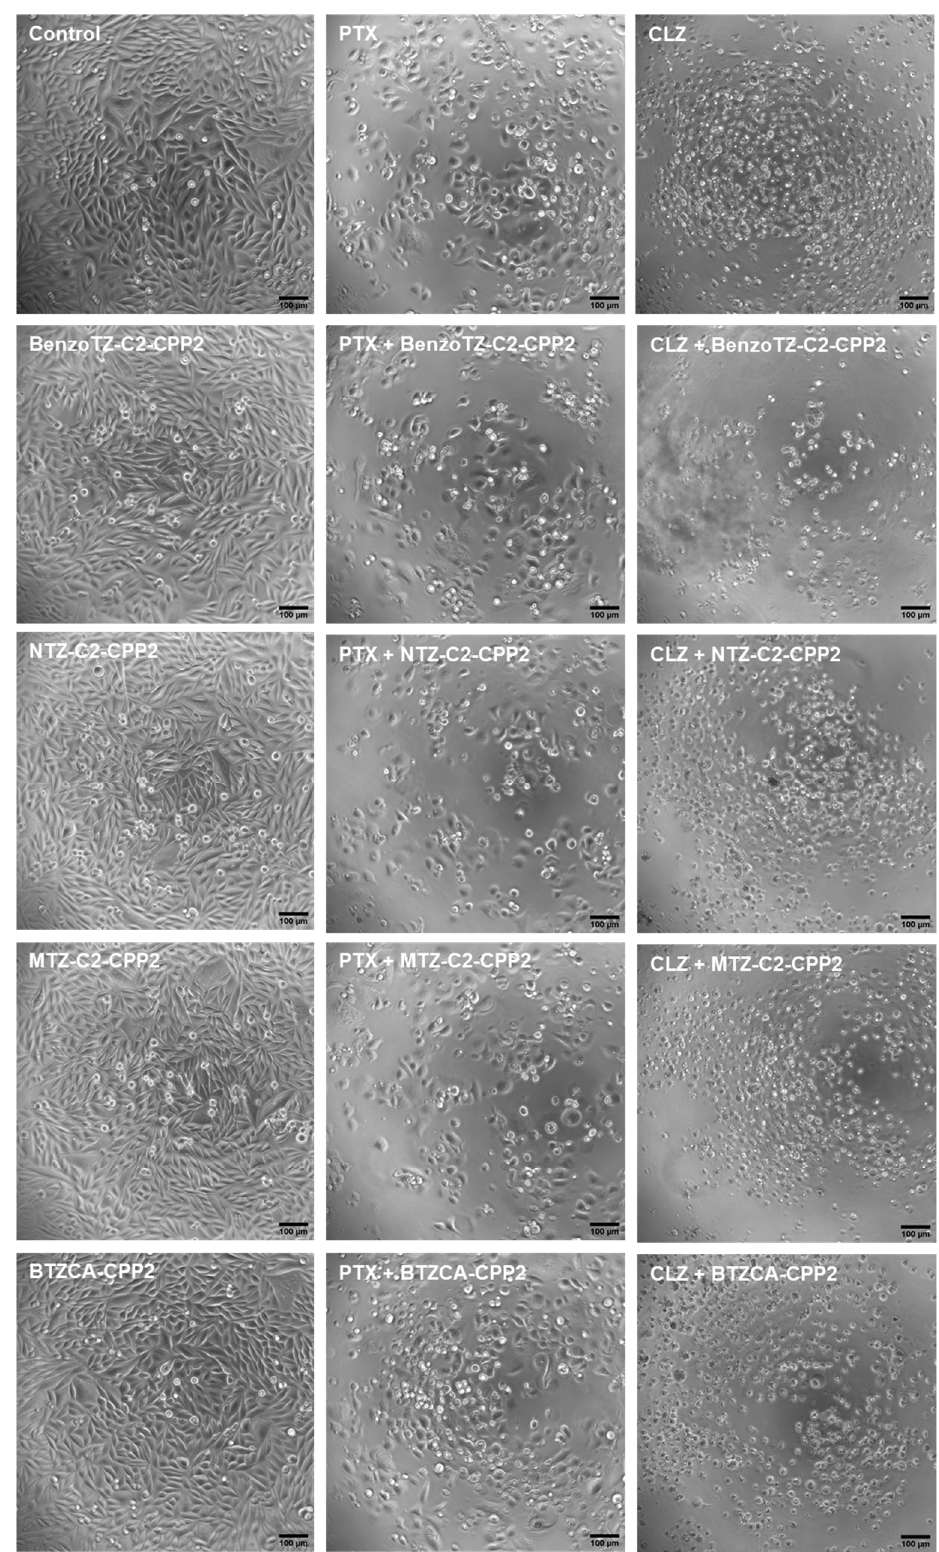
Figure 10. Microscopic visualisation of PC-3 treated with CPP2-thiazole derivates, both alone and combined with PTX and CLZ, at concentrations of 4 × IV. Representative images were obtained with a high contrast brightfield objective (10×) (LionHeart FX Automated Microscope) from three independent experiments. Scale bar: 100 µM.